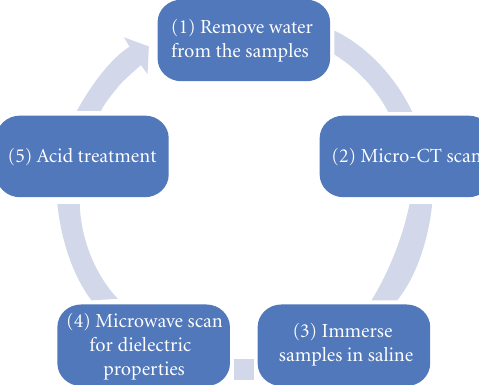
Figure 2: Experimental procedure flow for investigating the in vitro relationship between bone mineral and dielectric properties of porcine trabecular bone